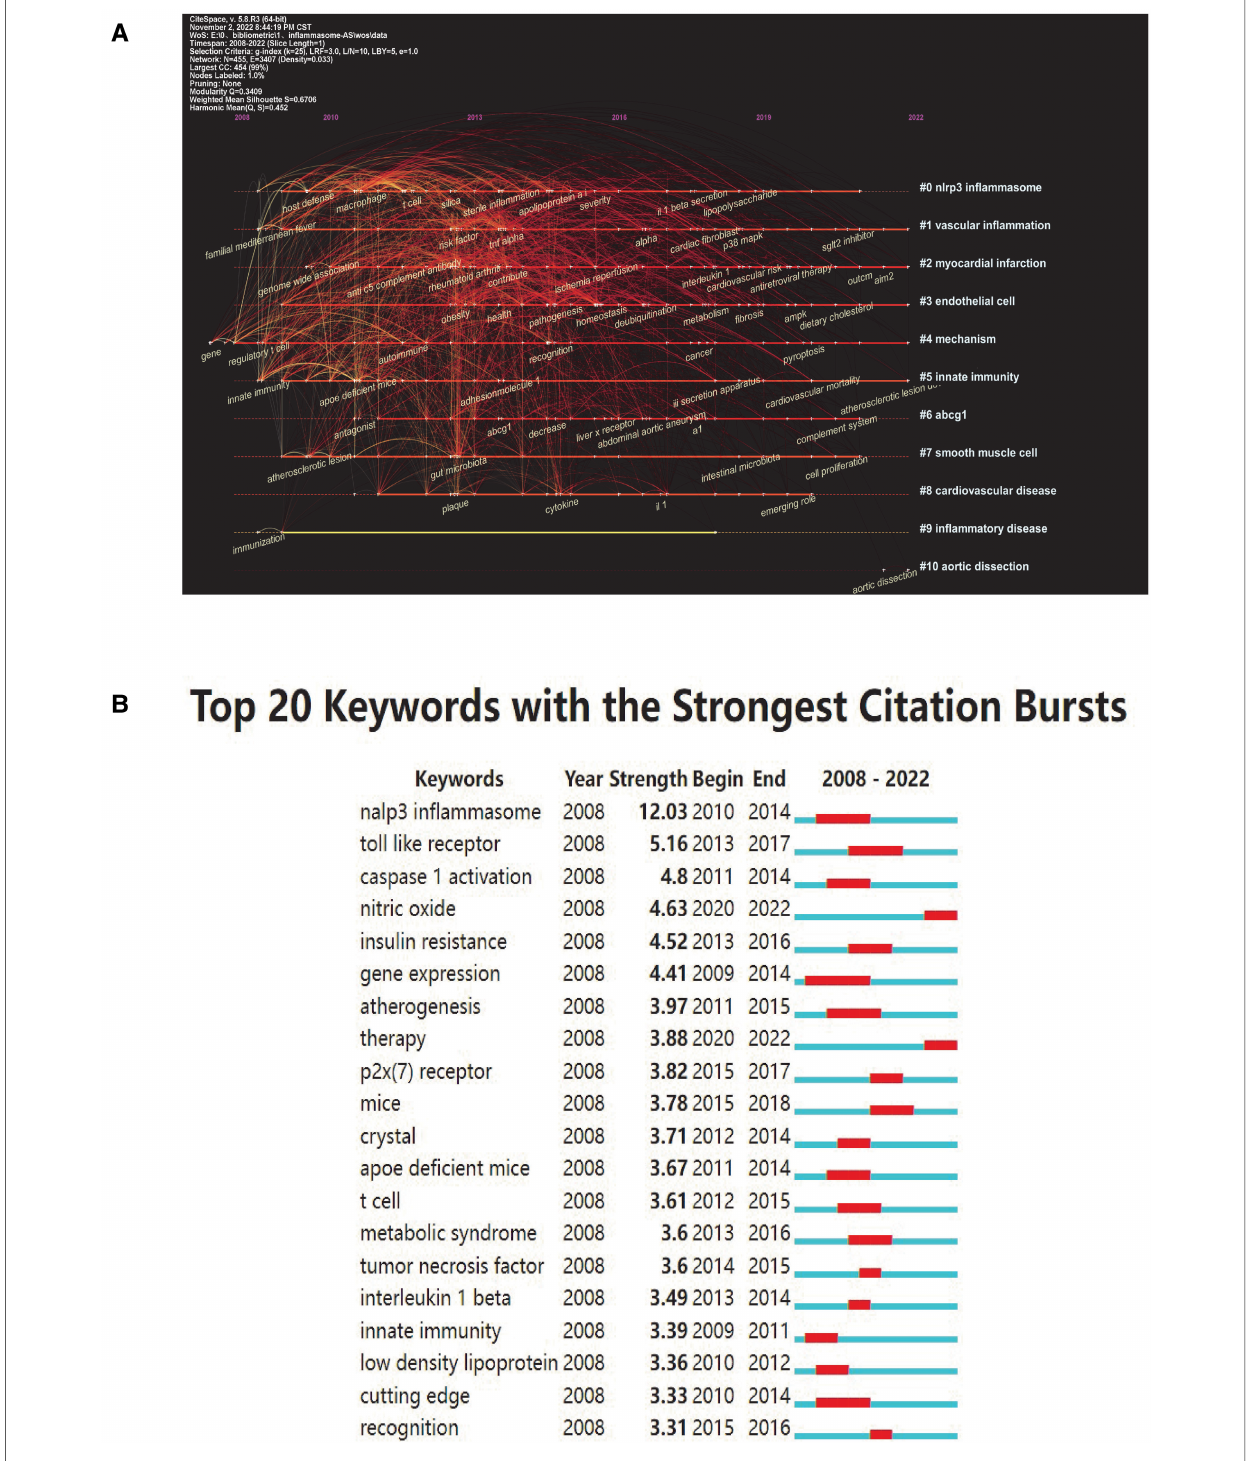
FIGURE 6 Keyword mapping. ( A ) Timeline distribution of keyword cluster analysis. Each horizontal line represents a cluster; the smaller the number, the larger the cluster, and #0 is the largest. The time is at the top, and keywords are located at their fi rst co-occurrence time in the cluster. Cluster labels were